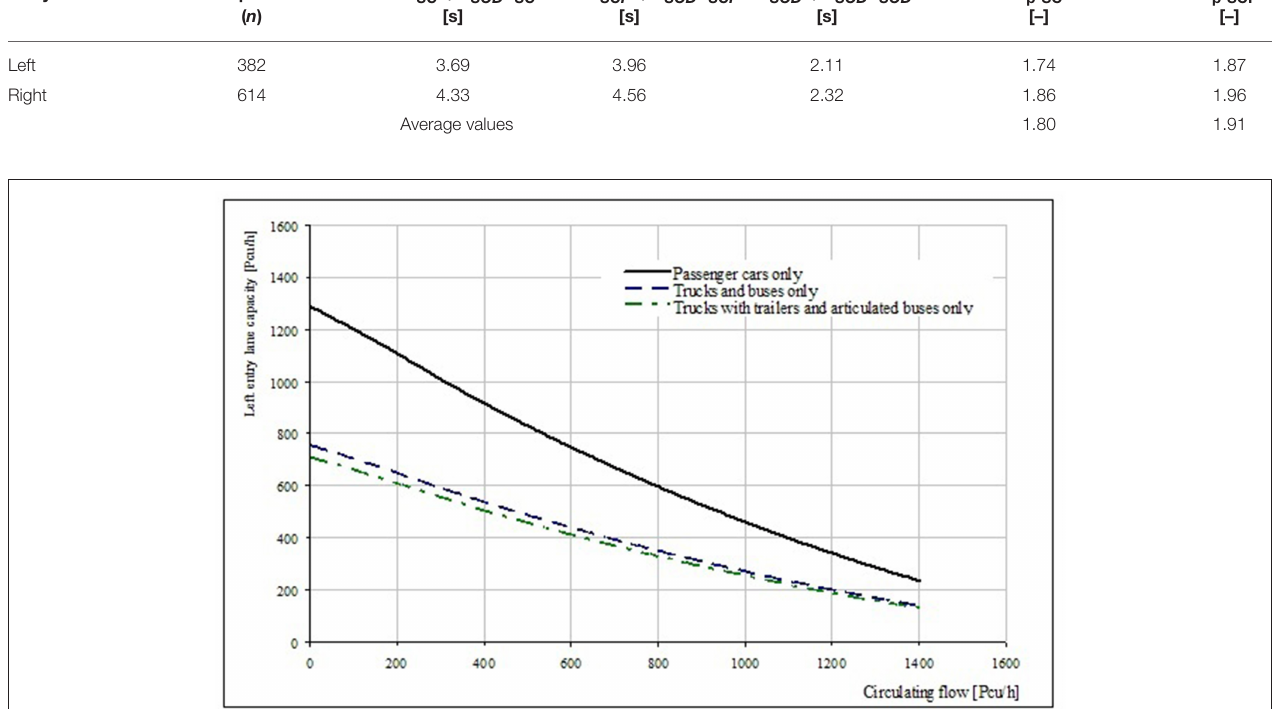
FIGURE 7 | Capacity of the left entry lane of the turbo roundabout for passenger cars only and heavy vehicles only.